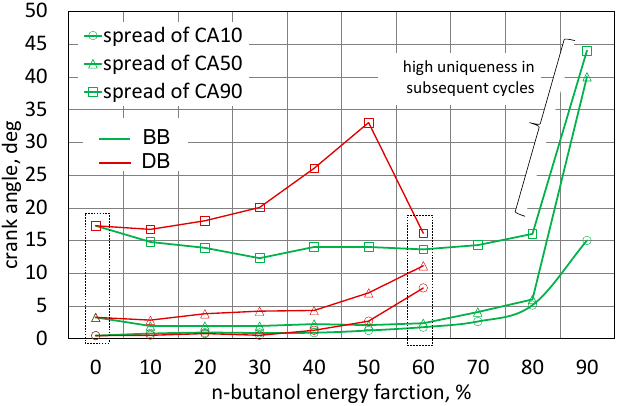
Figure 11. Spread the stages of combustion.